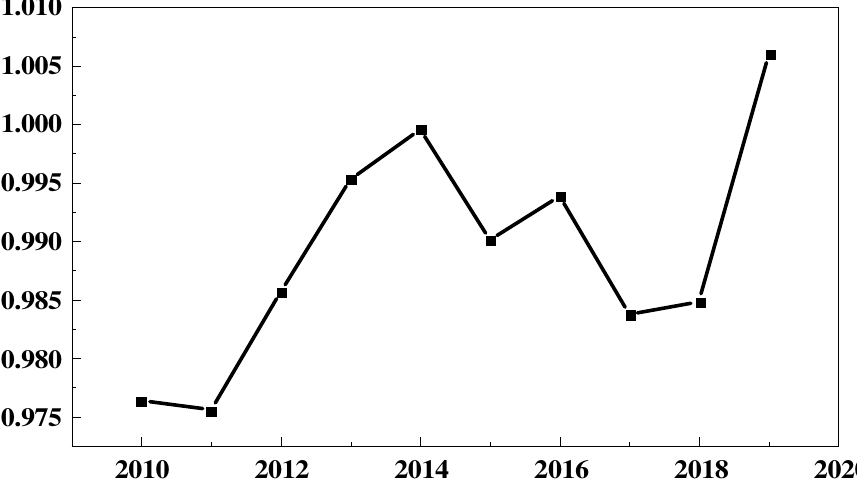
Figure 1. Trend of environmental performance of China’s power industry from the year 2010 to 2019.